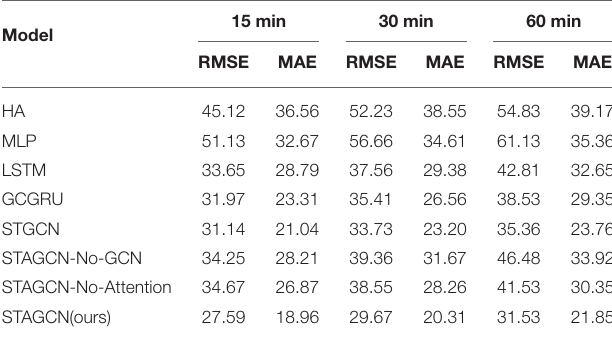
TABLE 1 | Comparison of prediction performances in different